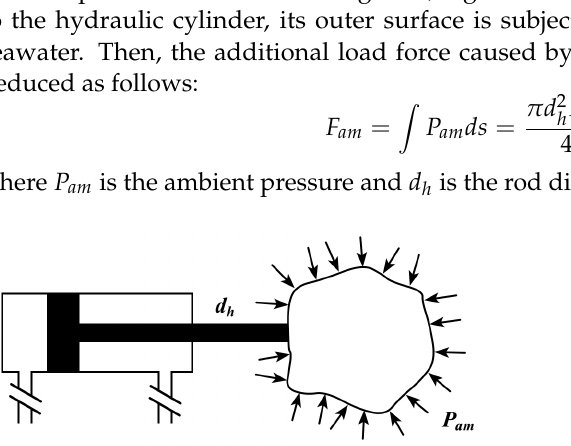
Figure 2. Ambient pressure load on the hydraulic